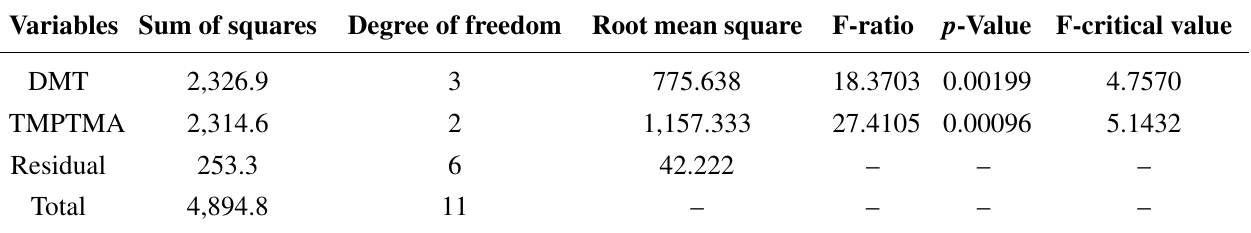
Table 4. Two-way ANOVA for working life of acrylic polymer concrete cured at ´ 10 ˝ C. Variables Sum of squares Degree of freedom DMT